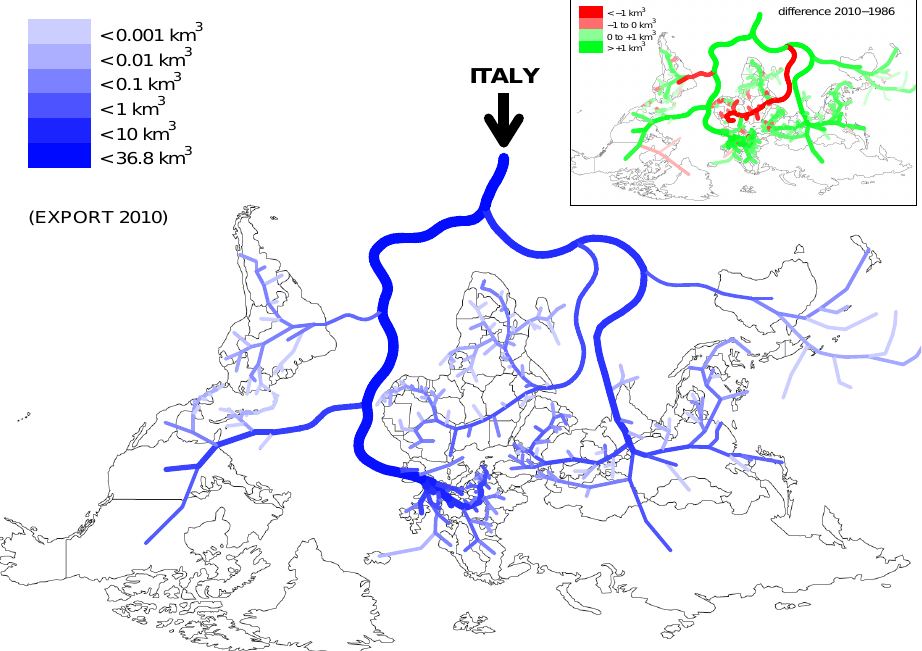
Fig. 2. The virtual water delta draining water from Italy in 2010: branches terminate in the trading countries and line thicknesses and colors indicate the virtual water volumes exported by Italy. Differences in export fluxes between 2010 and 1986 are reported in the inset. Hydrol. Earth Syst. Sci., 17, 1205–1215,